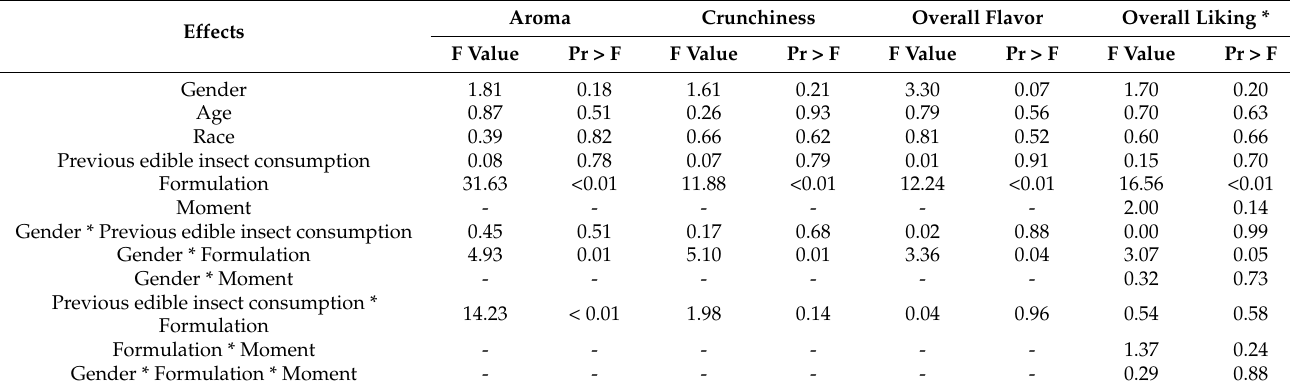
Table 3. ANOVA † table for sensory acceptability ‡ of treatments §